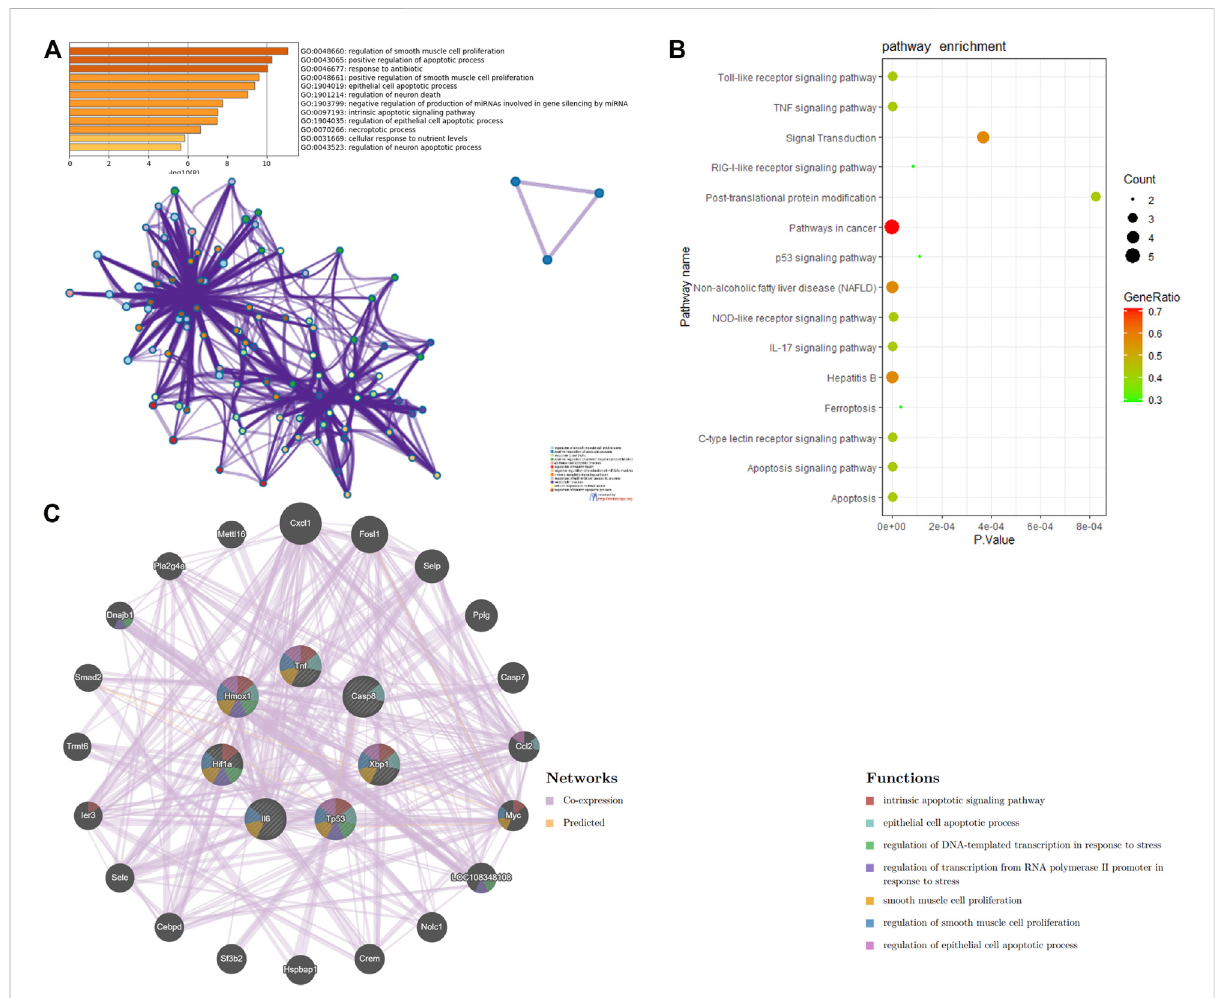
FIGURE 5 Functionanalysisofhubgenes. (A) functionalannotationanalysisofhubgenesusingMetascape. (B) pathwayanalysisofhubgenesbasedonthe KOBAS database. (C) network of hub genes and their coexpression genes were constructed and analyzed based on